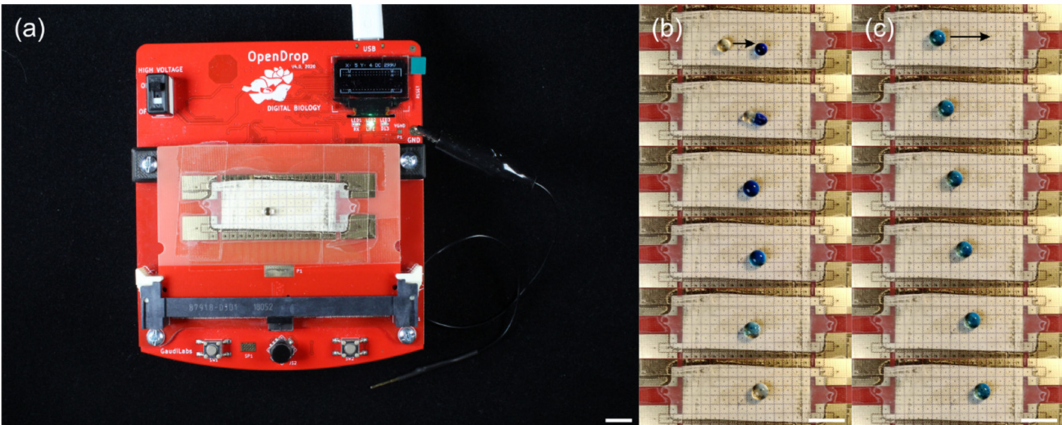
Figure 5. Droplet actuation on the commercial DMF OpenDrop device for performing a chemical assay. ( a ) DMF device OpenDrop with Fluoropor film mounted on the electrode array with a 20 µ L sized water droplet on top. Scale bar: 10 mm. ( b ) A chemical assay on the Fluoropor-covered electrodes by mixing of an Asc droplet (transparent) with a MB droplet (blue) resulted in a gradual discoloration of the MB after mixing, due to the reaction of the educts to the colorless product. ( c ) Droplet movement on Fluoropor film by electrowetting of a 30 µ L sized droplet with MB and Asc from left to right as indicated by the arrow. Scale bar: 10